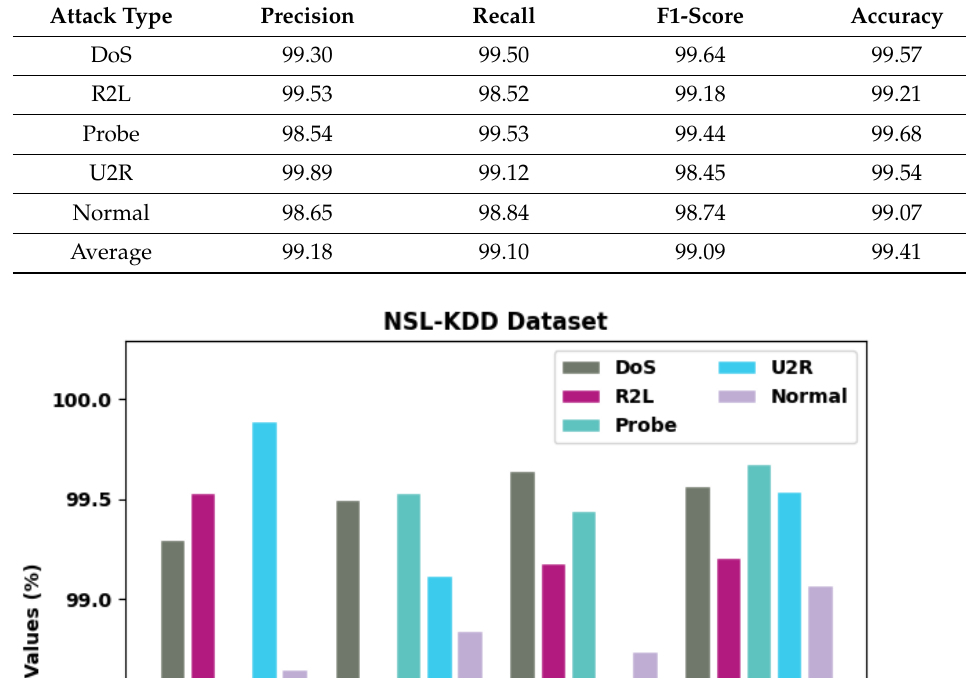
Table 2. Result analysis of OMLIDS-PBIoT technique on NSL-KDD dataset.